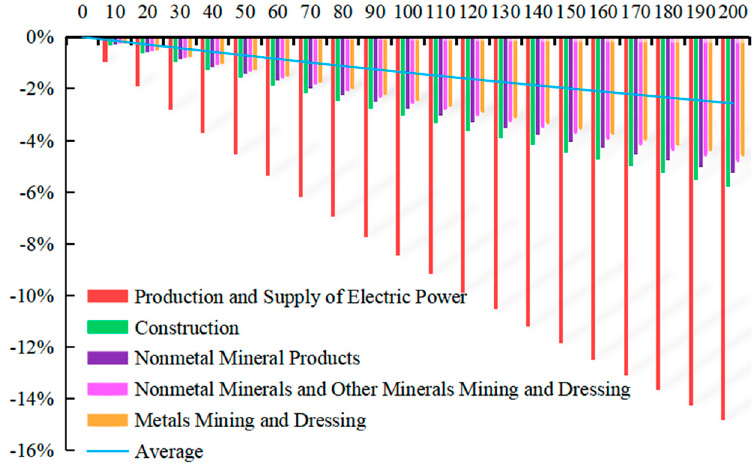
Figure 5. Impact of different carbon tax rates on the change of industrial employment.